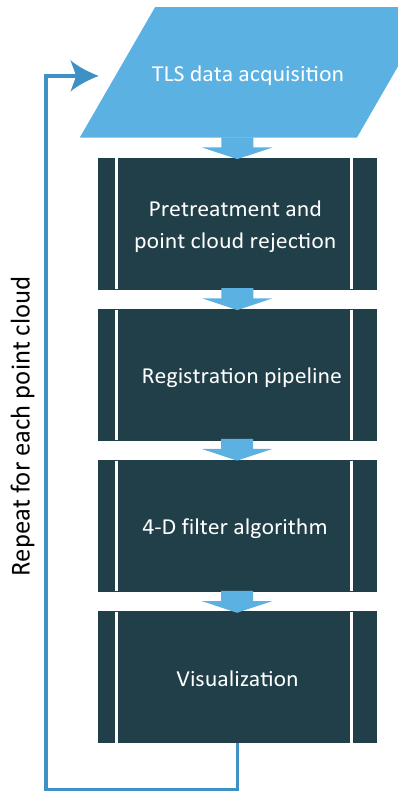
Figure 4. Near-real-time data processing workflow consisting of a data automated acquisition module, a pre-treatment and point cloud rejection stage, a rejection pipeline consisting of an initial align- ment and an iterative fine alignment stage, a 4-D filtering and dis- tance calculation algorithm (Kromer et al., 2015b) and a visualiza- tion module. This workflow is repeated for each point cloud acqui-